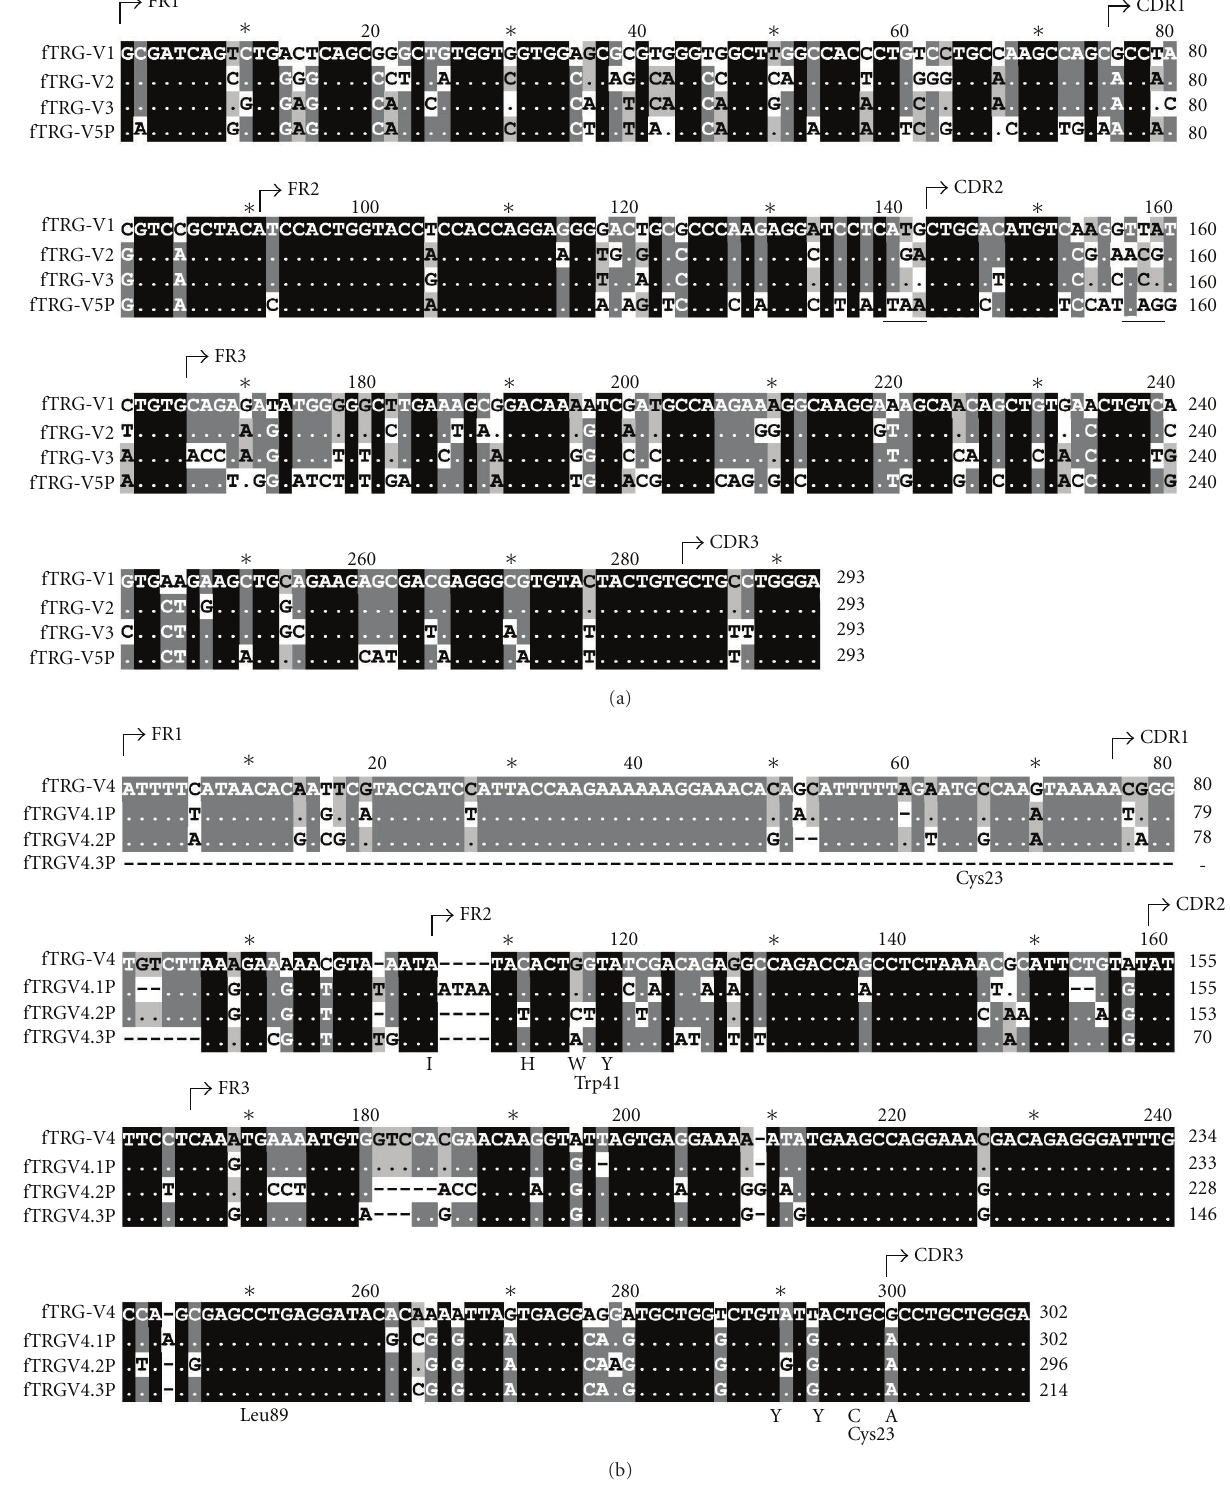
Figure 1: (a) Alignment of fTRGV5P (gnl | ti | 663092402) with previously published V-region genes of the feline TRG. The two stop codons are underlined (bp139–141 and bp157–159). (b) Alignment of fTRGV4 and the newly identified pseudogenes fTRGV4.1P (gnl | ti | 838072588, gnl | ti | 827924706), -4.2P (gnl | ti | 643947952, gnl | ti | 646819523, gnl | ti | 644534307), and -4.3P (gnl | ti | 631627457, > gnl | ti | 630610594, > gnl | ti | 2159892447). Conserved amino acids together with the unique IMGT-numbering [15] and characteristic motifs are indicated below the DNA